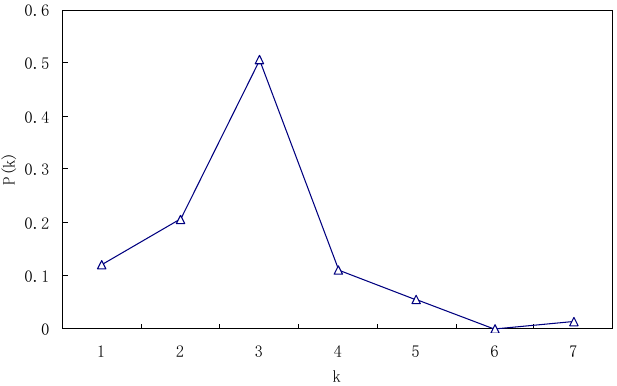
Figure 3. Sandstone pore network’s node degree distribution. The network clustering coefficient is used to measure the clustering of network nodes. The clustering coefficient of a node is the ratio of the number of edges of the node to the maximum number of edges of adjacent nodes, which can be expressed as